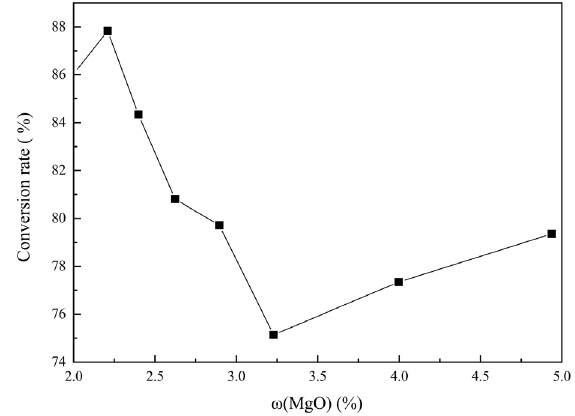
Figure 3. Effect of MgO content on vanadium conversion